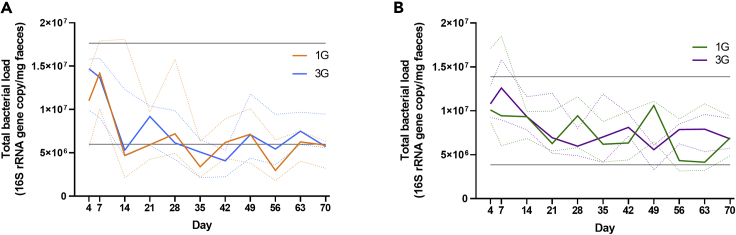
Bacterial load in fecal samples following establishment of gut microbiota in recipient germ-free miceDetermination of fecal total bacterial load in recipient mice that received (A) intact native microbiota or (B) microbiota derived from antibiotic-disrupted mice as a single (1G) or three rounds (3G) of gavage. Bacterial load was determined using quantitative PCR of the 16S rRNA gene. The top and bottom gray lines denote the maximum and minimum bacterial load of donor fecal samples. Solid lines and dotted lines denote median values and interquartile ranges, respectively. Statistical comparison between groups were performed using the Mann-Whitney test at a level of p < 0.05 for significance.